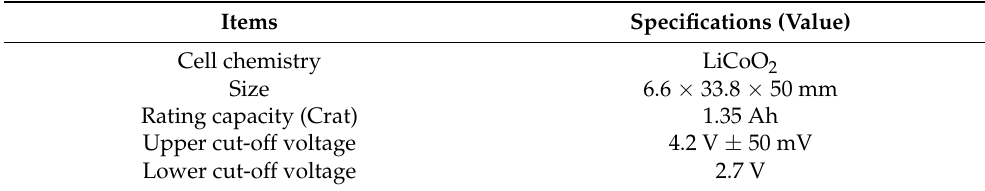
Figure 3. ( a ) Constant current discharge curves; ( b ) maximum available capacity curves; and ( c ) the OCV-SOC curves at different cycle times. Table 3. Key specifications of employed test battery